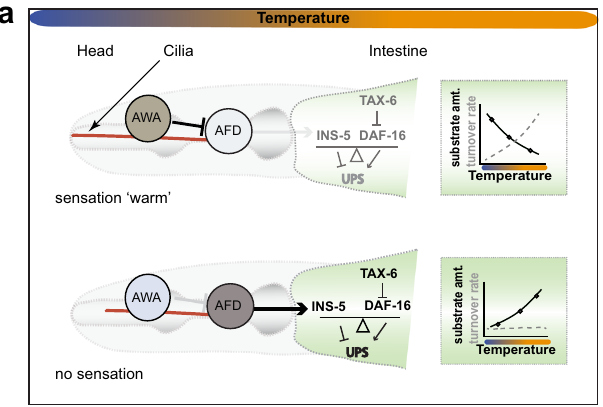
Fig. 8 | Sensory temperature perception and proteostasis regulation. a In WT worms, external stimuli, such as warm temperature, are perceived and processed normally via sensory neurons such as AWA (and possibly other sensory neurons, including ASH), reducing AFD signalling (sensation ‘ warm ’ ). The red lines sche- matically show the length of all cilia, which are longer in WT, whereas the distal segmentsareabsentinthe dyf-1(mn335) mutant.UPSfunctionintheintestinedoes not primarily depend on INS-5 or calcineurin signalling. Thus, WT worms increase their protein degradation in response to warm temperature (dotted line in the graph), resulting in decreased amounts of proteasomal substrates (substrate amt. dark line) at higher temperature (substrate amt. dark line). dyf-1(-) mutant worms exhibit defects in distal cilia formation and are unable to properly sense ambient temperature (no sensation) due to decreased AWA function creating a neuronal signalthatinvolvestheaberrantfunctionoftheAFDneuronswhichfailtosensethe ambienttemperaturecorrectly(indicatedbyblackarrow).ThissignalincludesDCV secretion and the neuropeptide FLP-3 that blocks the UPS in the intestine. The inducedAFDsignalincreasesINS-5toreduceUPSfunction.Inparallel, tax-6 loss-of- function is tipping the balance towards the action of DAF-16 to control the UPS. Hence, dyf-1 (-) worms failto adjust theirproteindegradation rate (dotted grey line in the graph) due to loss of temperature sensation and accumulate proteasomal substrates (dark line in the